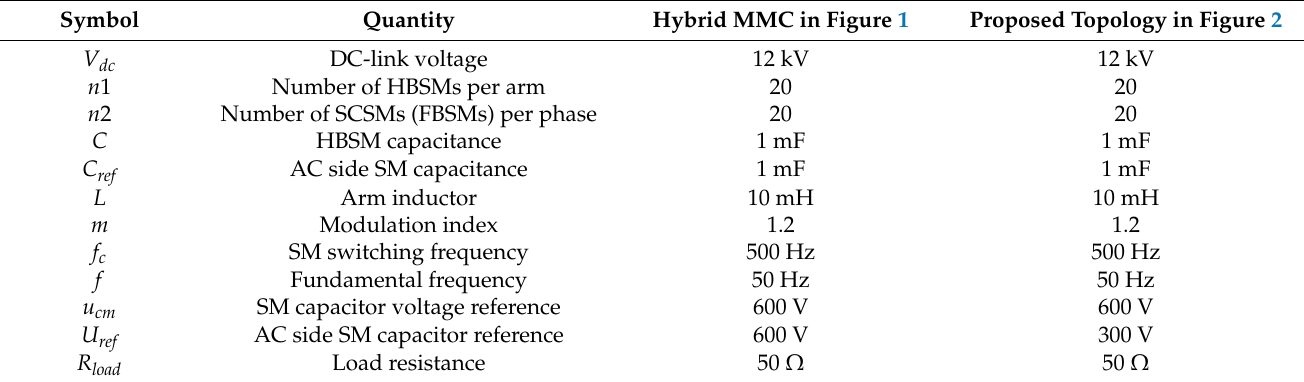
Table 2. Circuit parameters for loss calculation.